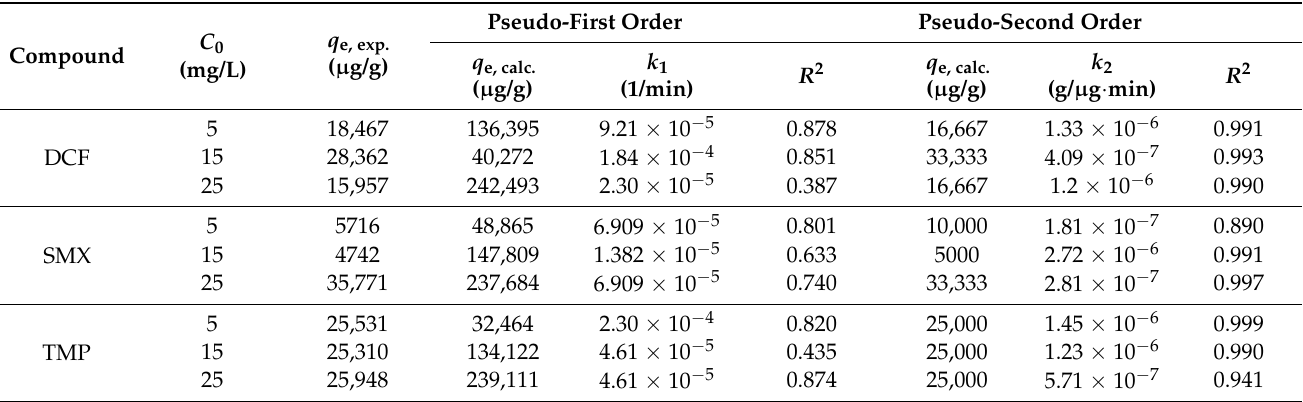
Table 4. Sorption kinetic parameters for the mixture of DCF, SMX and TMP in ultra-pure water with 0.1 g/L of added PAC.